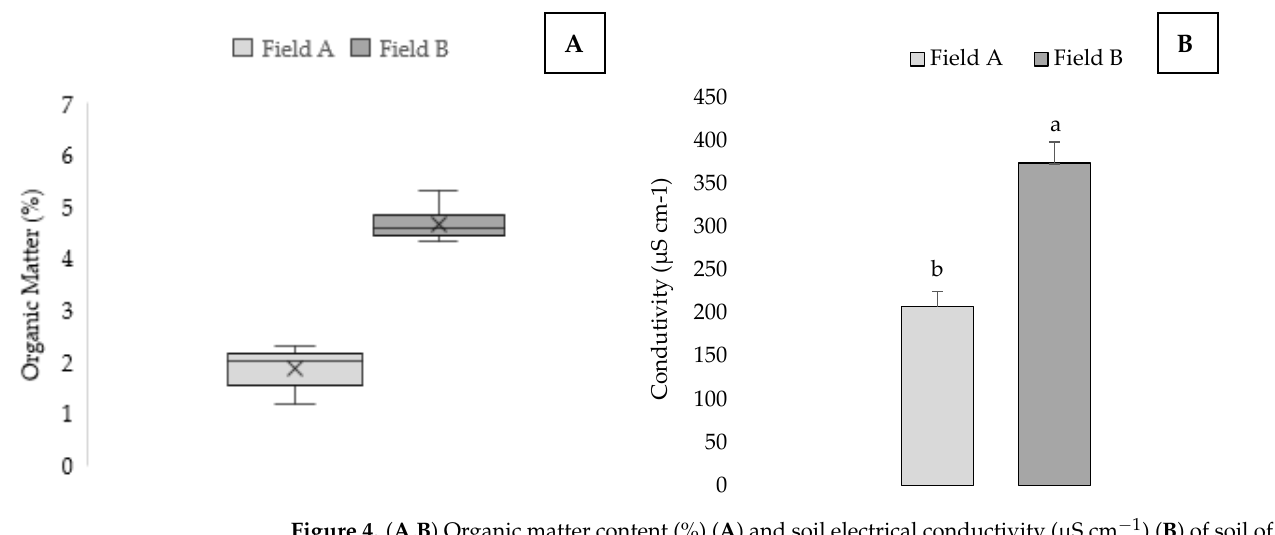
Figure 4. ( A,B ) Organic matter content (%) ( A ) and soil electrical conductivity ( µ S cm − 1 ) ( B ) of soil of both fields (Field A and Field B). Different letters after (a, b) express significant differences between Field A and Field B in condutivity.